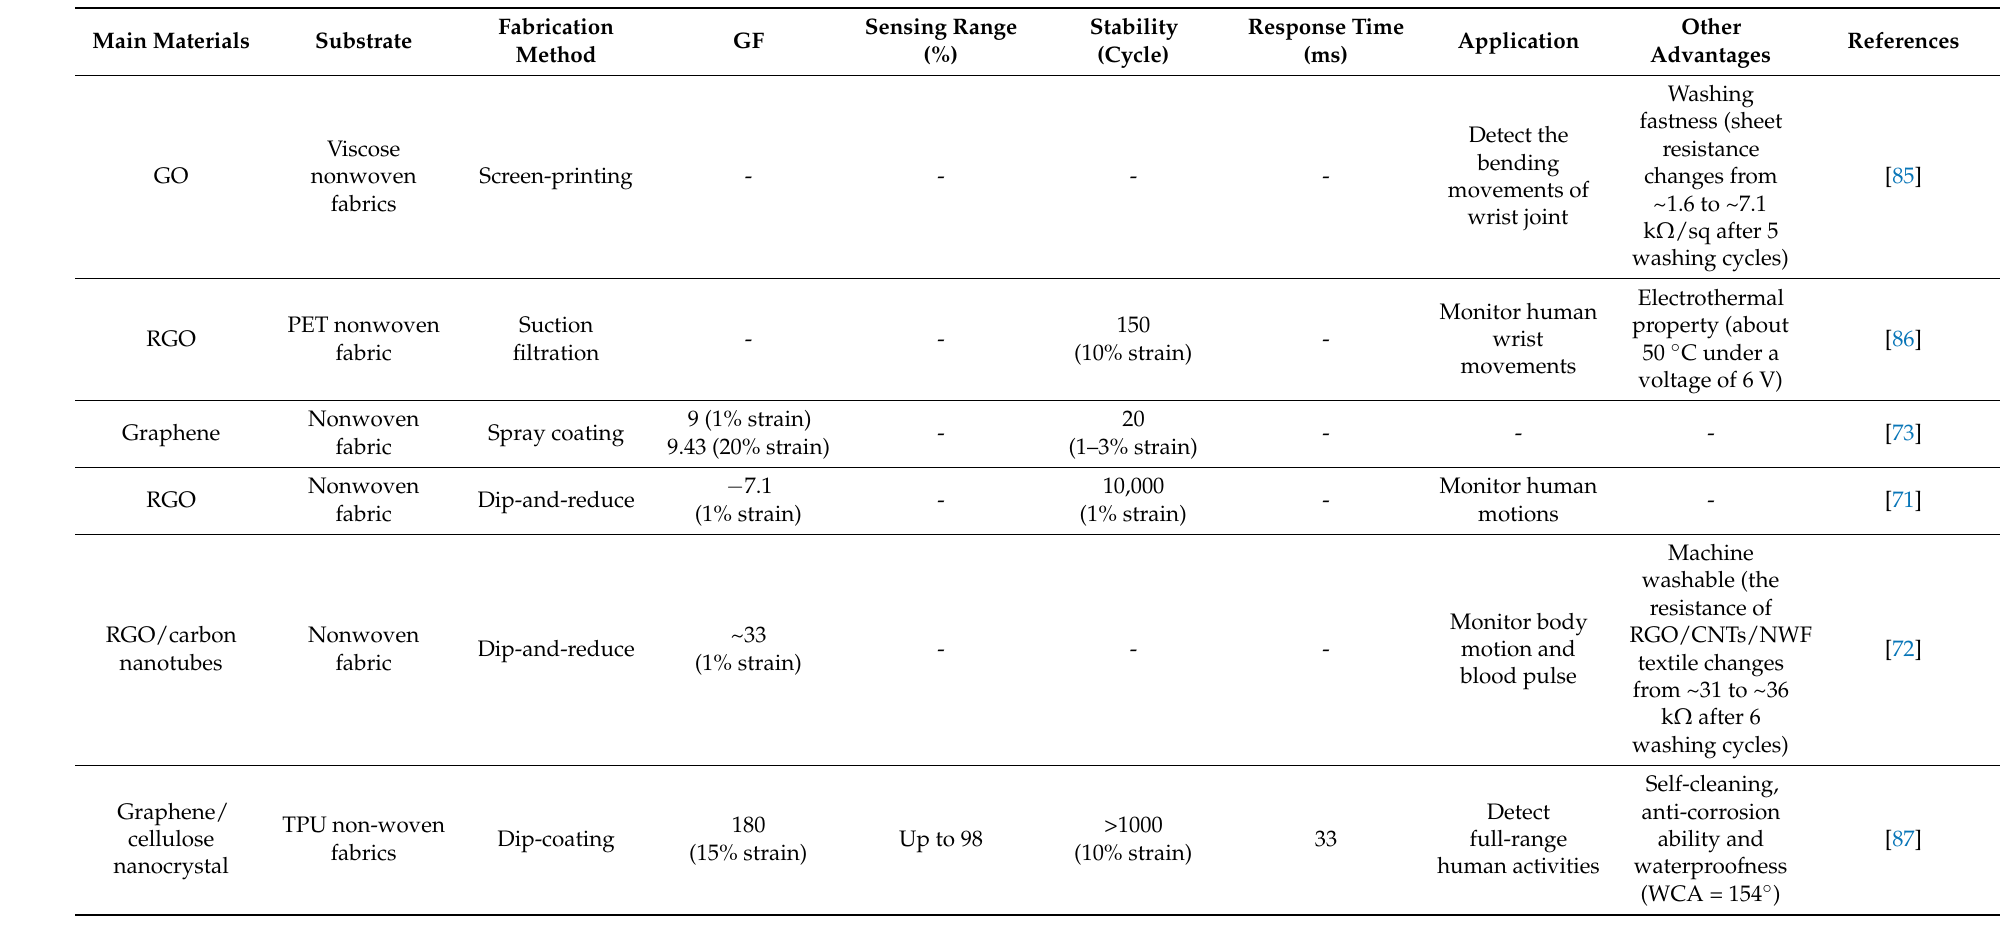
Table 3. Performance of various graphene-based nonwoven strain